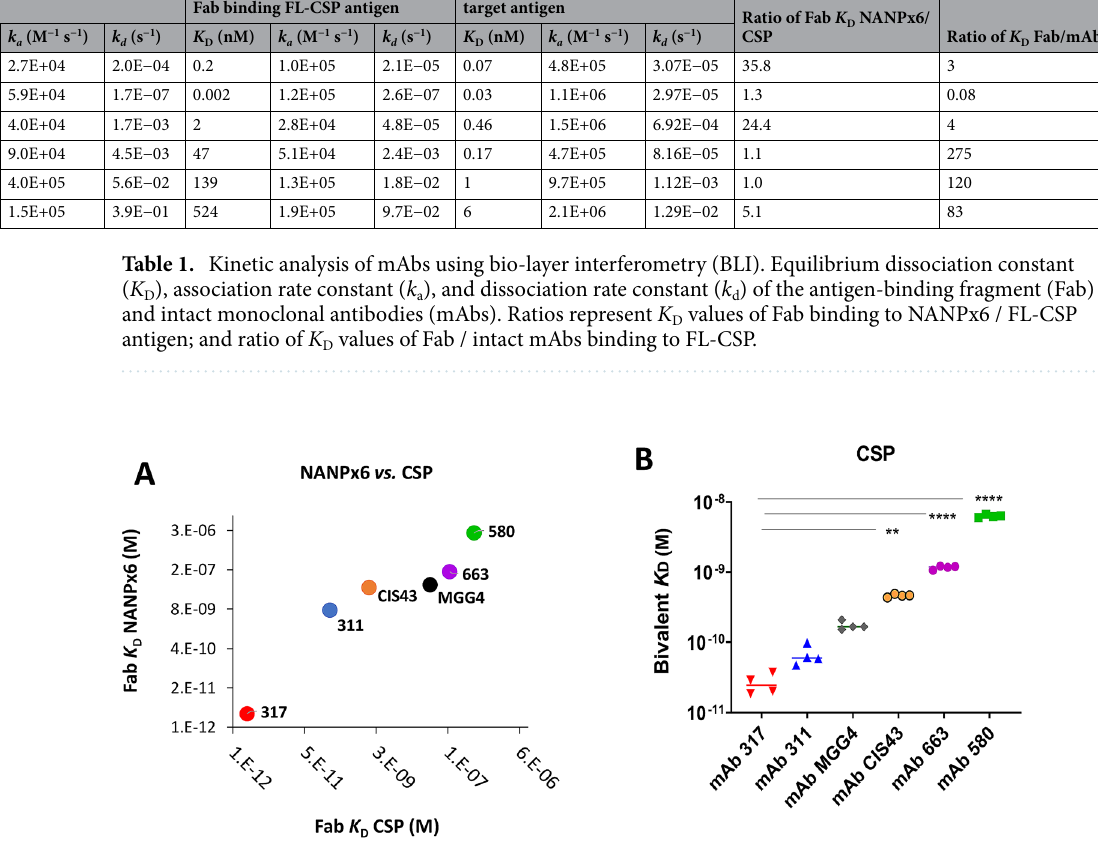
Figure 4. Affinity by Biolayer Interferometry (BLI). ( A ) Antibody binding fragment (Fab) dissociation constant ( K D ) against NANPx6 vs. CSP antigen determined by BLI (Octet; ForteBio, Freemont CA). Global fit to a 1:1 Langmuir binding model was used, experiment was performed twice on at least four concentrations of Fab (raw data Table S2, Figs. S2, S3). ( B ) Mean bivalent mAb dissociation constants ( K D ) against FL-CSP determined by BLI performed as four independent experiments on two different Octet instruments ( raw data Table S2). Comparisons against mAb 317; (*) indicate level of significance for K D value differences determined by ANOVA and p values corrected for multiple comparisons by Tukey’s